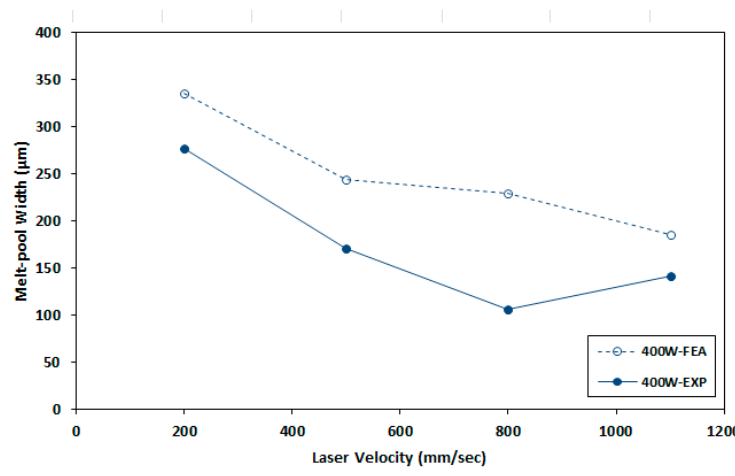
Figure 7. Melt-pool width of Ti-64 beads at 400 W laser power and 200–1100 mm / s sweeping speed.